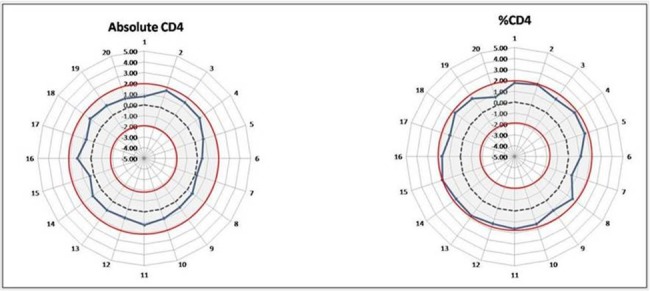
External quality assessment results.Radar graphs summarizing the results obtained with external quality assessment samples for absolute CD4 counts (left, including 10 trials, each with a low and a normal CD4 count on each respective trial) and CD4% of lymphocytes (right), both indicated by solid blue lines revealing the performance of the Aquios in relation to the respective 10 supplied retrospective trial pool means. The solid red lines indicate the acceptable 2 standard deviation range, while the interrupted black line represents the average overall performance (ideal) of the pooled results (at an SDI of zero).